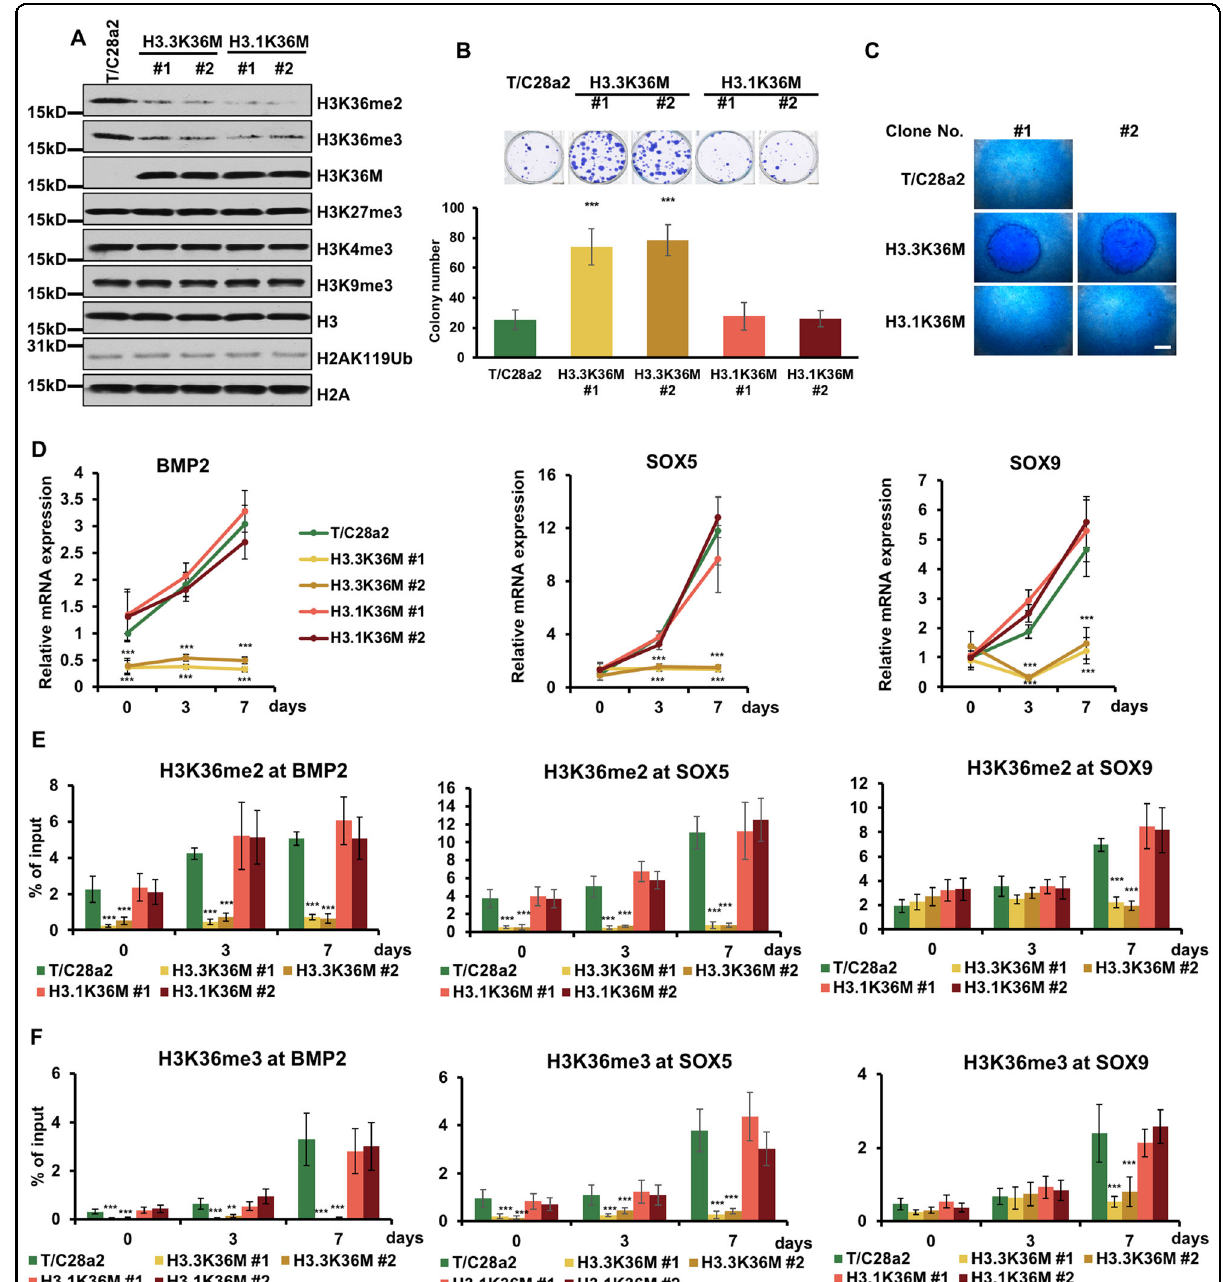
Fig. 1 H3.3K36M-mutant cells show cancer-related cellular phenotypes. A H3.3K36M and H3.1K36M knock-in reduced the H3K36me2 and H3K36me3 levels in chondrocyte cell lines. Cell extracts were analyzed via western blotting using the indicated antibodies. B H3.3K36M-mutant cells showed increased colony formation ability. The results are represented by the mean ± SD ( N = 3 independent replicates, *** p < 0.001). C H3.1K36M- mutant cells undergo normal chondrogenic differentiation. Alcian blue staining of differentiated micromasses are shown. Scale bars: 50 μ m. D The expression levels of chondrogenic differentiation markers, including BMP2, SOX5, and SOX9, were analyzed via RT-RCR and normalized to GAPDH. The expression levels of the genes in T/C28a2 cells before differentiation were normalized as 1. The samples of day 0 were collected after seeding as micromass. E The H3K36me2 enrichment at BMP2, SOX5, and SOX9 was analyzed. WT, H3.3K36M-, and H3.1K36M-mutant cells were differentiated for 0, 3, and 7 days. At each time point, ChIP DNA at the indicated loci were calculated against the input DNA. F As in E , except the H3K36me3 enrichment at the indicated loci was analyzed. The results in D – F are represented by the mean ± SD ( N = 3 independent replicates, ** p < 0.01, *** p <